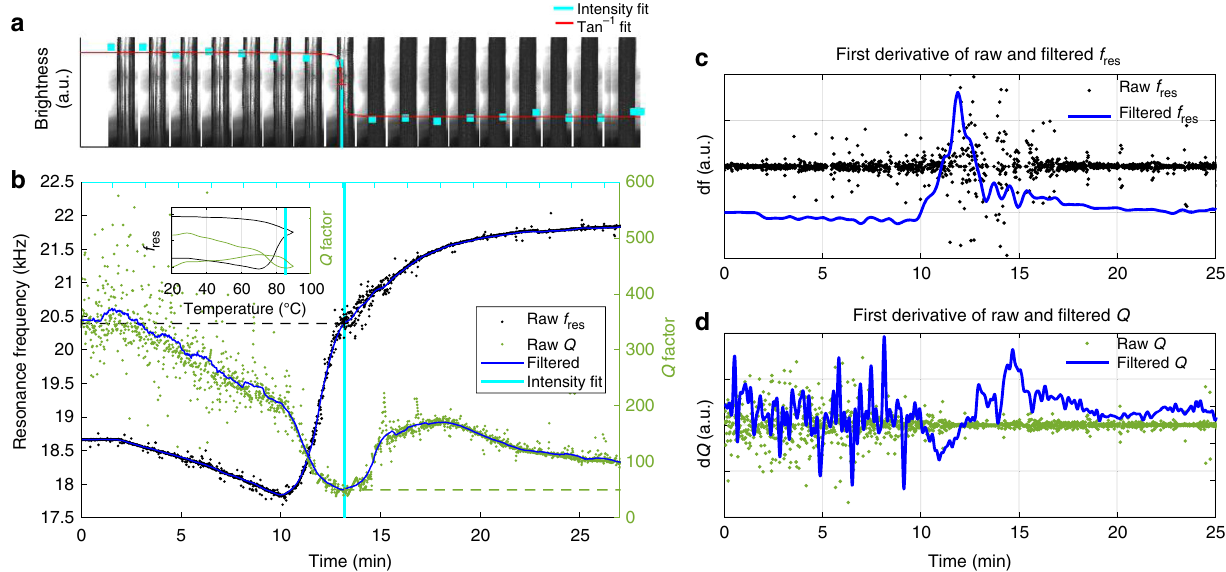
Fig. 2 Proof of concept for PMTA from a single experiment. a A series of optical images of a single TP MH particle (1000 μ m × 65 μ m, cantilever) during dehydration (25 – 90 – 25 °C, 5 °C /min) with its tracked intensity (arctan function was fi tted). b PMTA thermogram showing the raw data for tracking of f res and Q of TP MH during heating and cooling with the temperature plot inset. c , d First derivative plots from the tracked and fi ltered f res and Q data in b